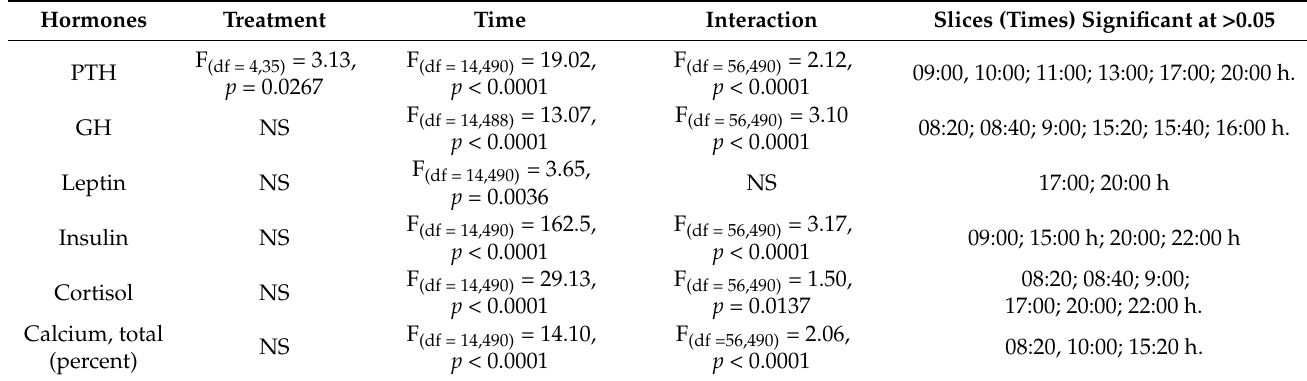
Table 7. Group differences for five hormones resulting from timing of meals and exercise.